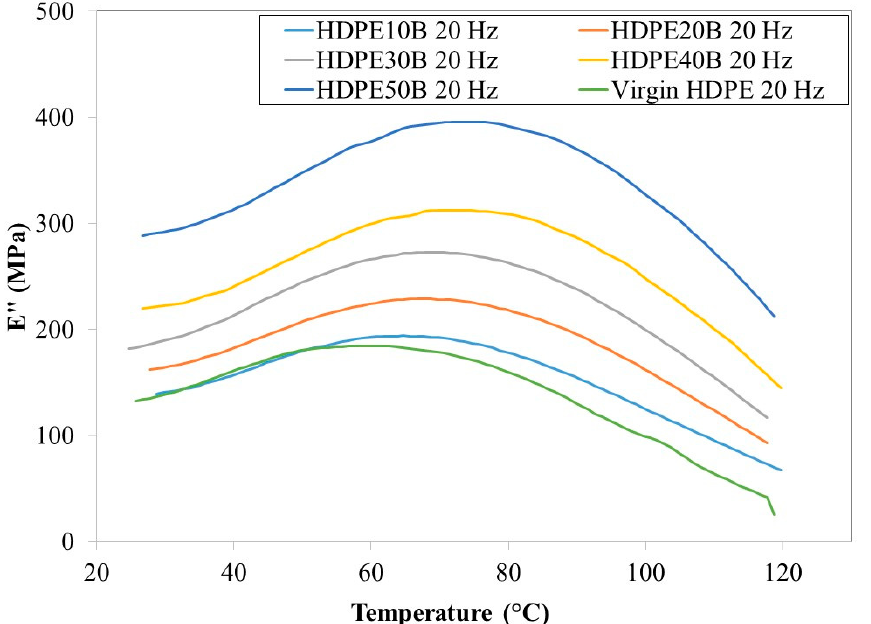
Figure 8. Loss modulus of HDPE/birch fiber composites at 1 Hz.